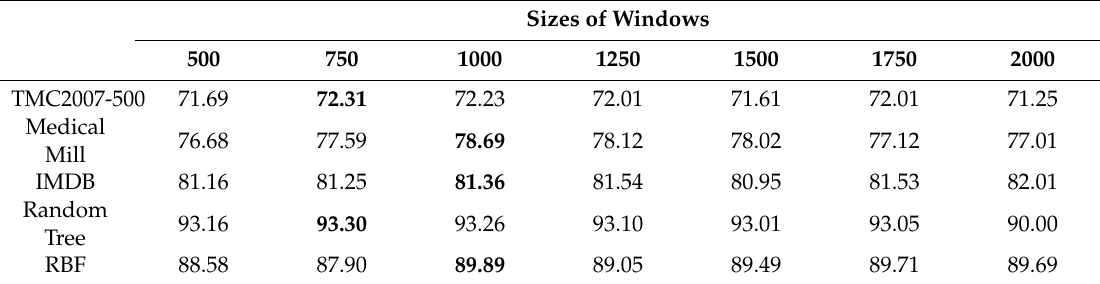
Table 3. Subset accuracy using different sizes of windows.